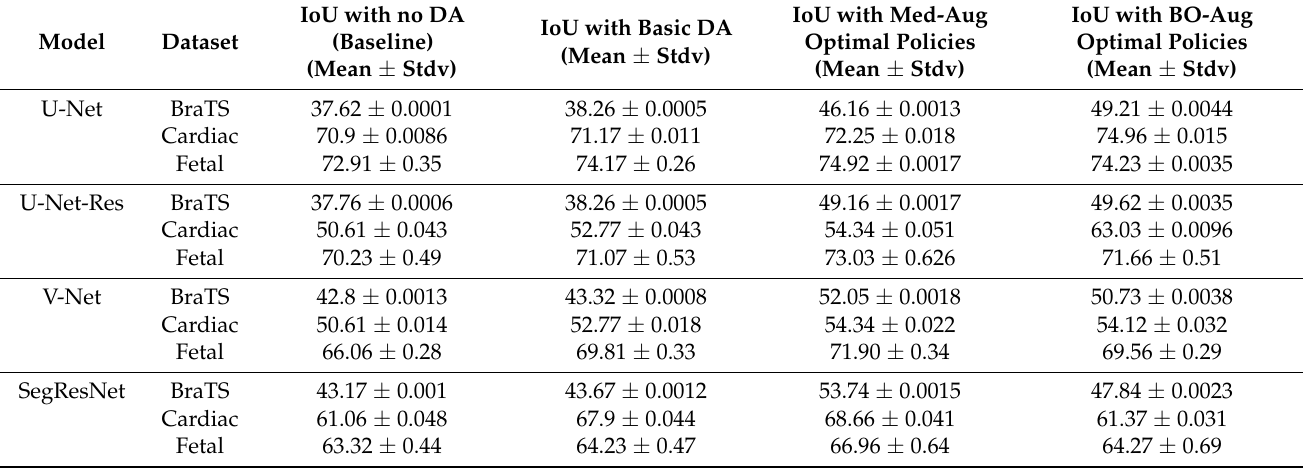
Table A3. Testing performance in IoU of four different neural networks using different DA policies on the training set.